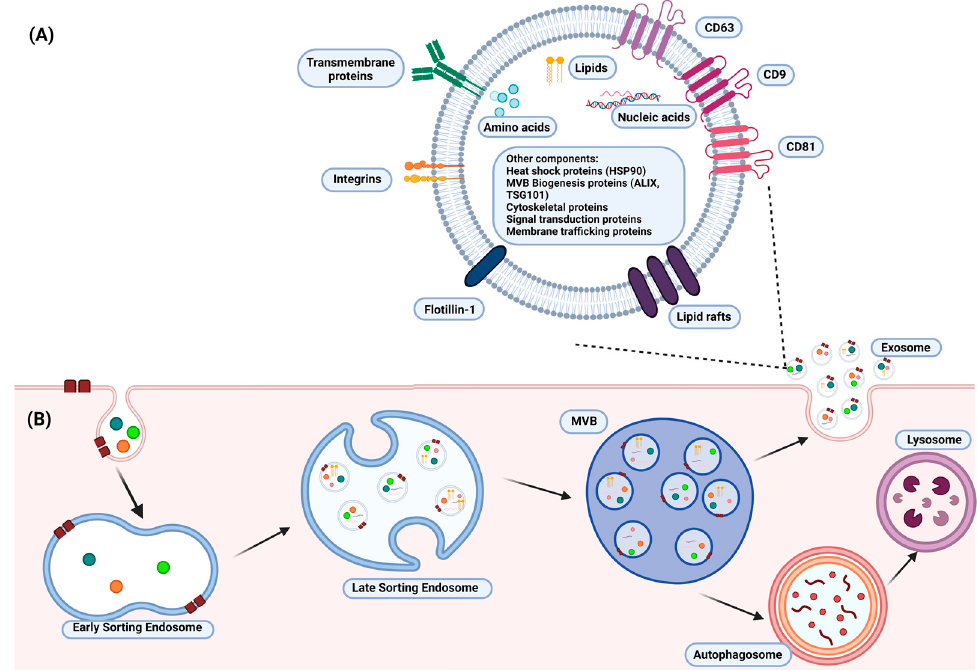
Figure 1. A schematic illustration of ( A ) the structure of a typical exosome and ( B ) the formation of exosomes. The structure of the exosome consists of intracellular (lipids, nucleic acids, and proteins) and extracellular components (tetraspanins, lipid rafts, flotillin-1, and transmembrane proteins), which assist in its characterization and many cellular functions. Exosomes are produced from a multivesicular body (MVB), which arises from a late-sorting endosome (LSE). The biogenesis of exosomes also involves specific sorting mechanisms responsible for transportation and an intraluminal vesicle (ILV) budding in the LSE. The illustration was created with BioRender.com (https://app.biorender.com; accessed on 16 January 2023).